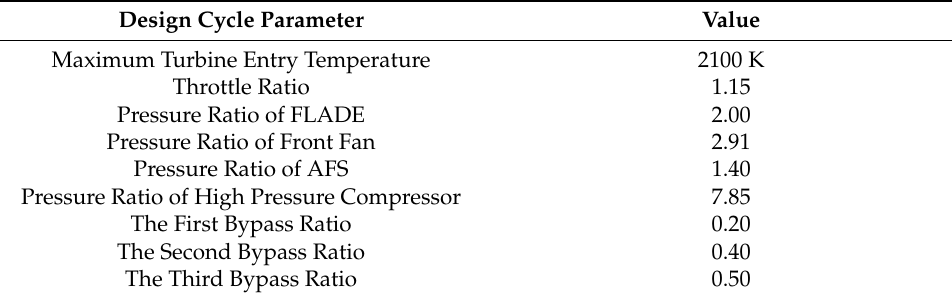
Table 1. Main Design Cycle Parameters of Adaptive Cycle Engine.